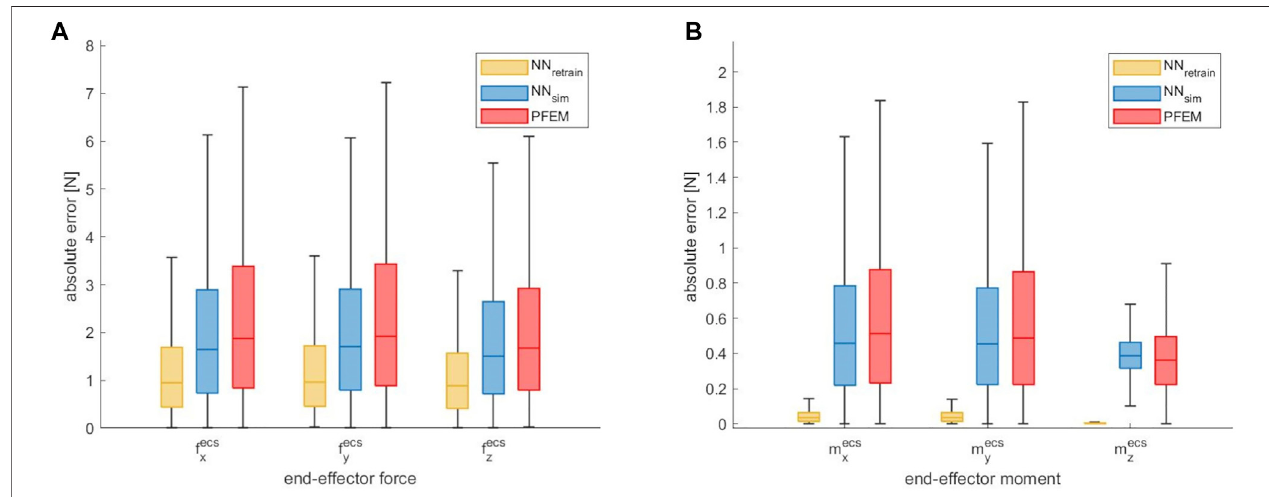
FIGURE7| Absoluteend-effectorforceerror (A) andmomenterror (B) oftheANNapproachcomparedtothePFEMgivenforeachaxisinlinearscale,evaluatedon the transfer data of the KUKA iiwa 14 R820 dataset transf .